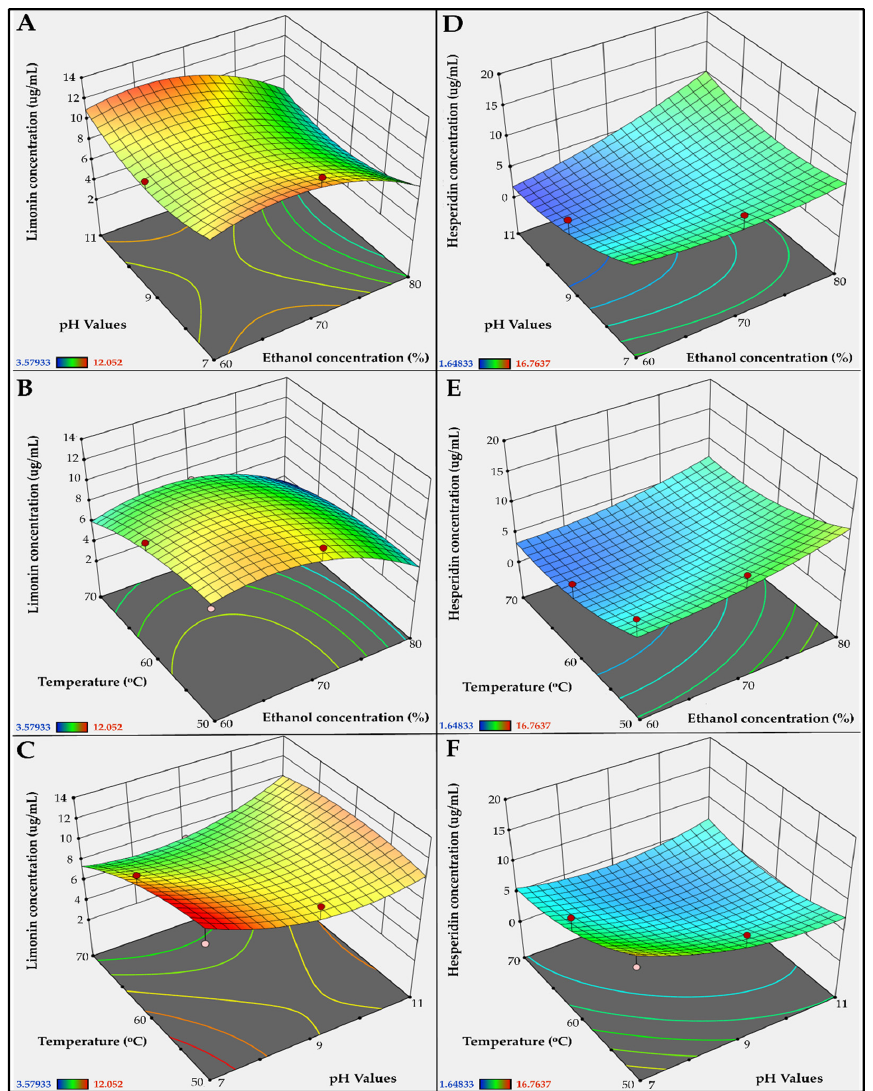
Figure 4. Relationship between extraction factors. Three-dimensional (3D) response surface method- ology (RSM) diagrams show concentrations of limonin ( A – C ) and hesperidin ( D – F ) in the ethanolic- aqueous extracts of lime peel as the function of ethanol concentration, extraction temperature, and pH value of extraction solvent. Red, yellow, green and blues areas depict the highest to lowest concentrations of limonin and